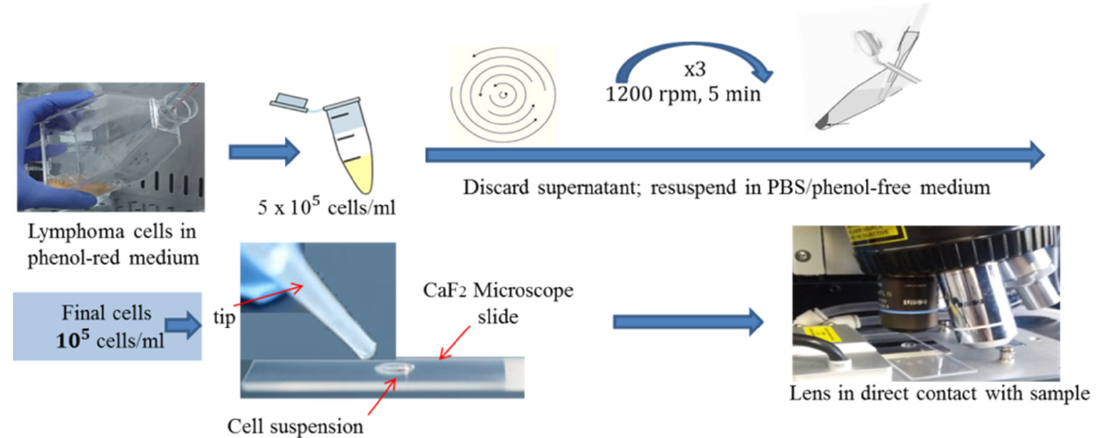
Figure 1. Sample preparation process.